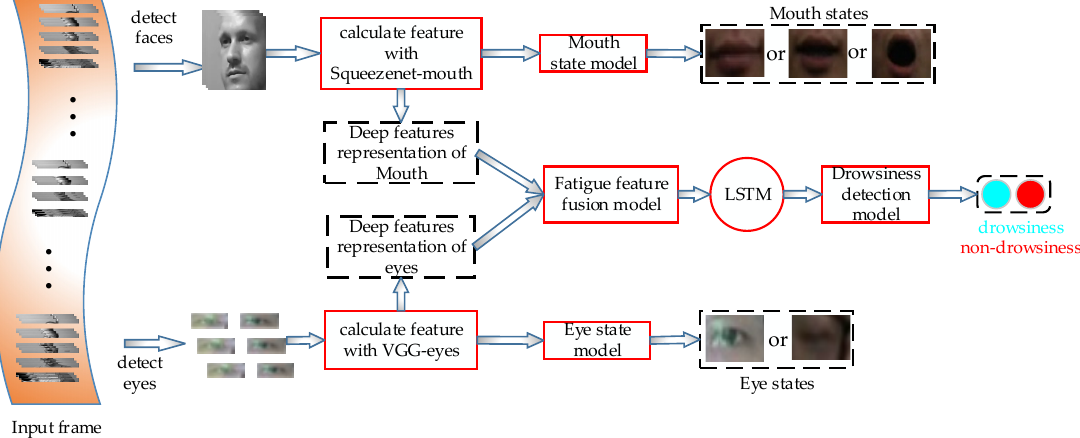
Figure 1. Overall architecture of the proposed framework. The red boxes denote the models, and the black boxes drawn with dotted lines define the extracted features or outputs of each model.